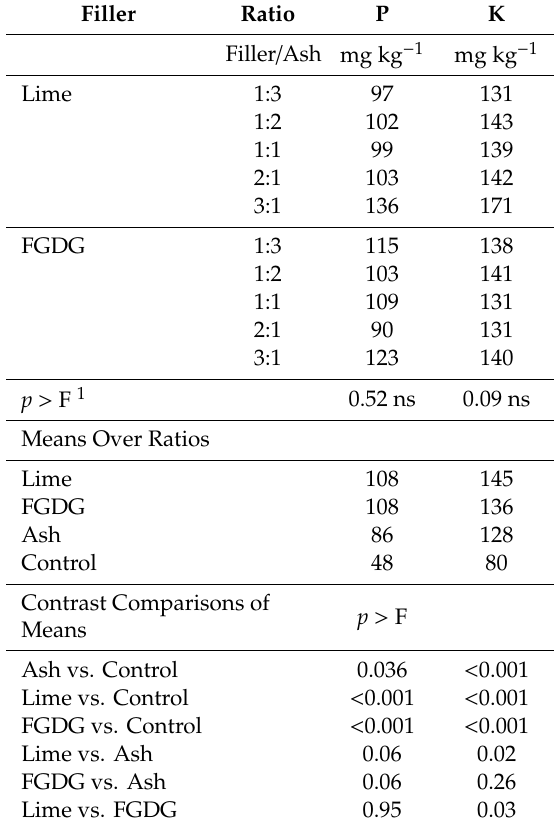
Table 4. Soil Available P and K (Mehlich-1) as a ff ected by poultry litter ash amendment and filler / ash ratio. Soil was collected from pots after a 30-day incubation period. Filler Ratio P K Filler / Ash mg kg − 1 mg kg − 1 Lime 1:3 97 131 1:2 102 143